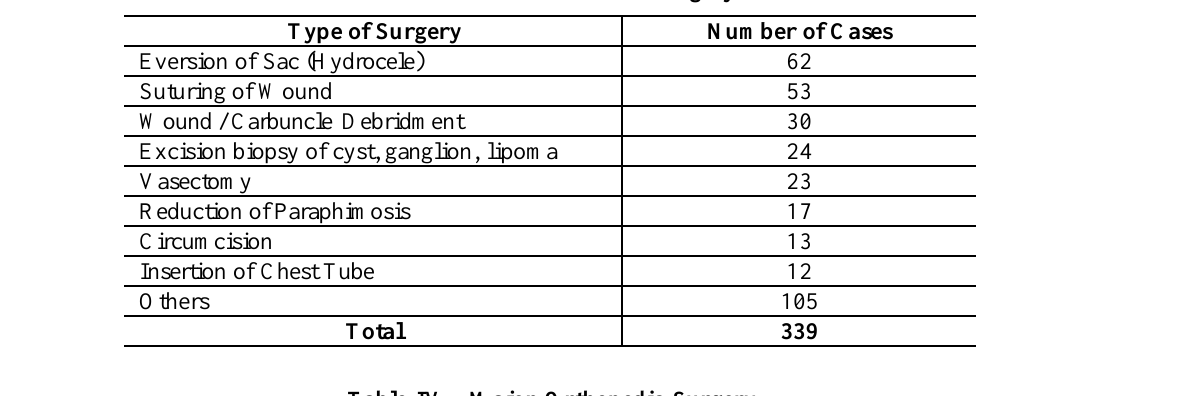
Table III : Minor General surgery